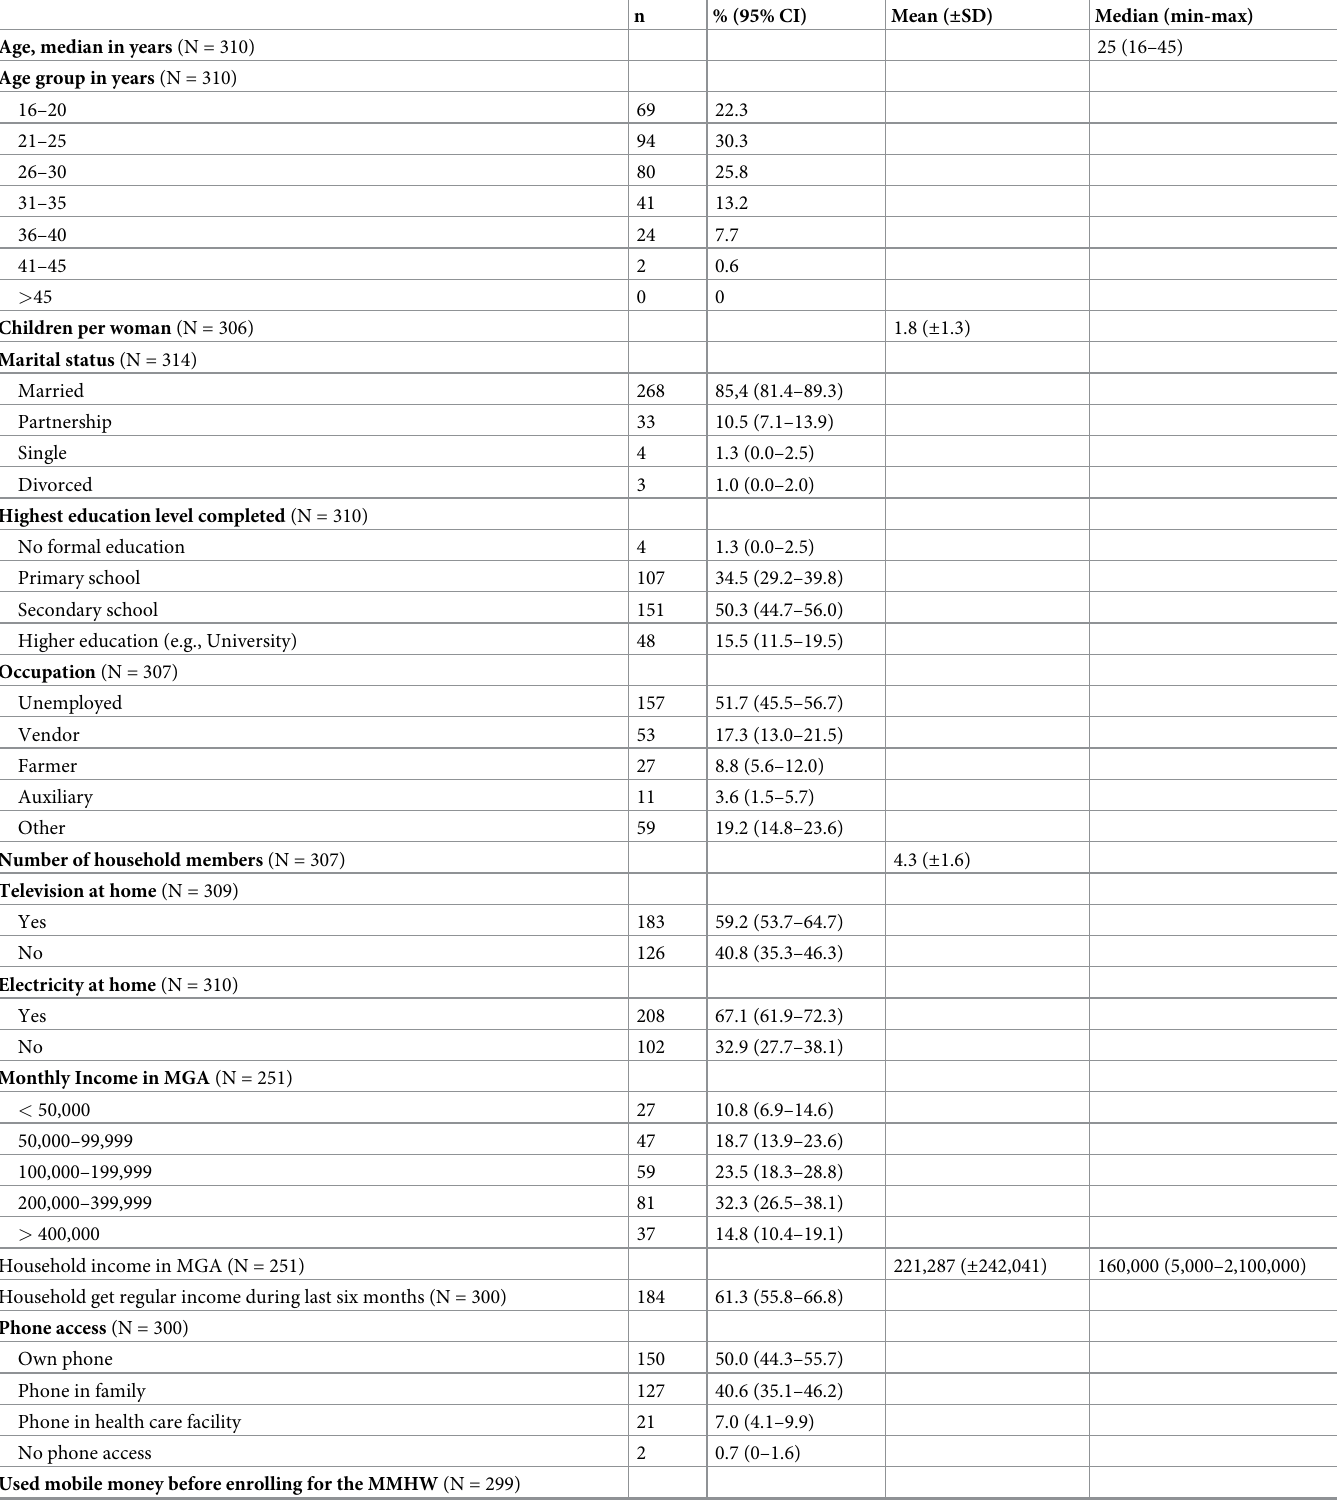
Table 1. Socio-demographic characteristics and previous experiences with mobile money of mothers and pregnant women participating in this study (N =